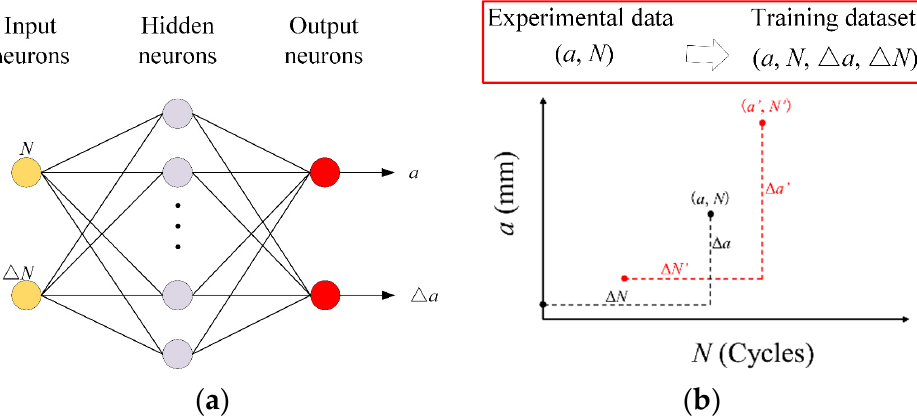
Figure 3. ( a ) Schematic diagram of NN structure for NNIL method and ( b ) the way to construct dataset during testing process.